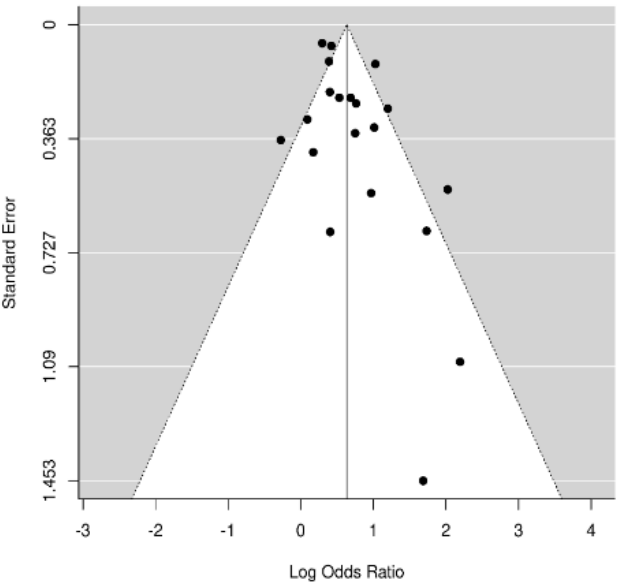
Figure 3. Risk of atrial fibrillation (AF) in patients with obstructive sleep apnea (OSA). Funnel plot. The results were further analyzed for the possible effects of sex, age, diabetes mellitus, hypertension, and BMI. The respective diagrams are shown in Figures 4–8. Age ( p = 0.04) and hypertension ( p = 0.04) were found to affect the incidence of OSA in AF patients. An increase of 5 years corresponded to a reduction by 9.4% in incidence of AF. In contrast, no effect was found for sex (0.44), diabetes mellitus ( p = 0.62), and BMI ( p = 0.9).